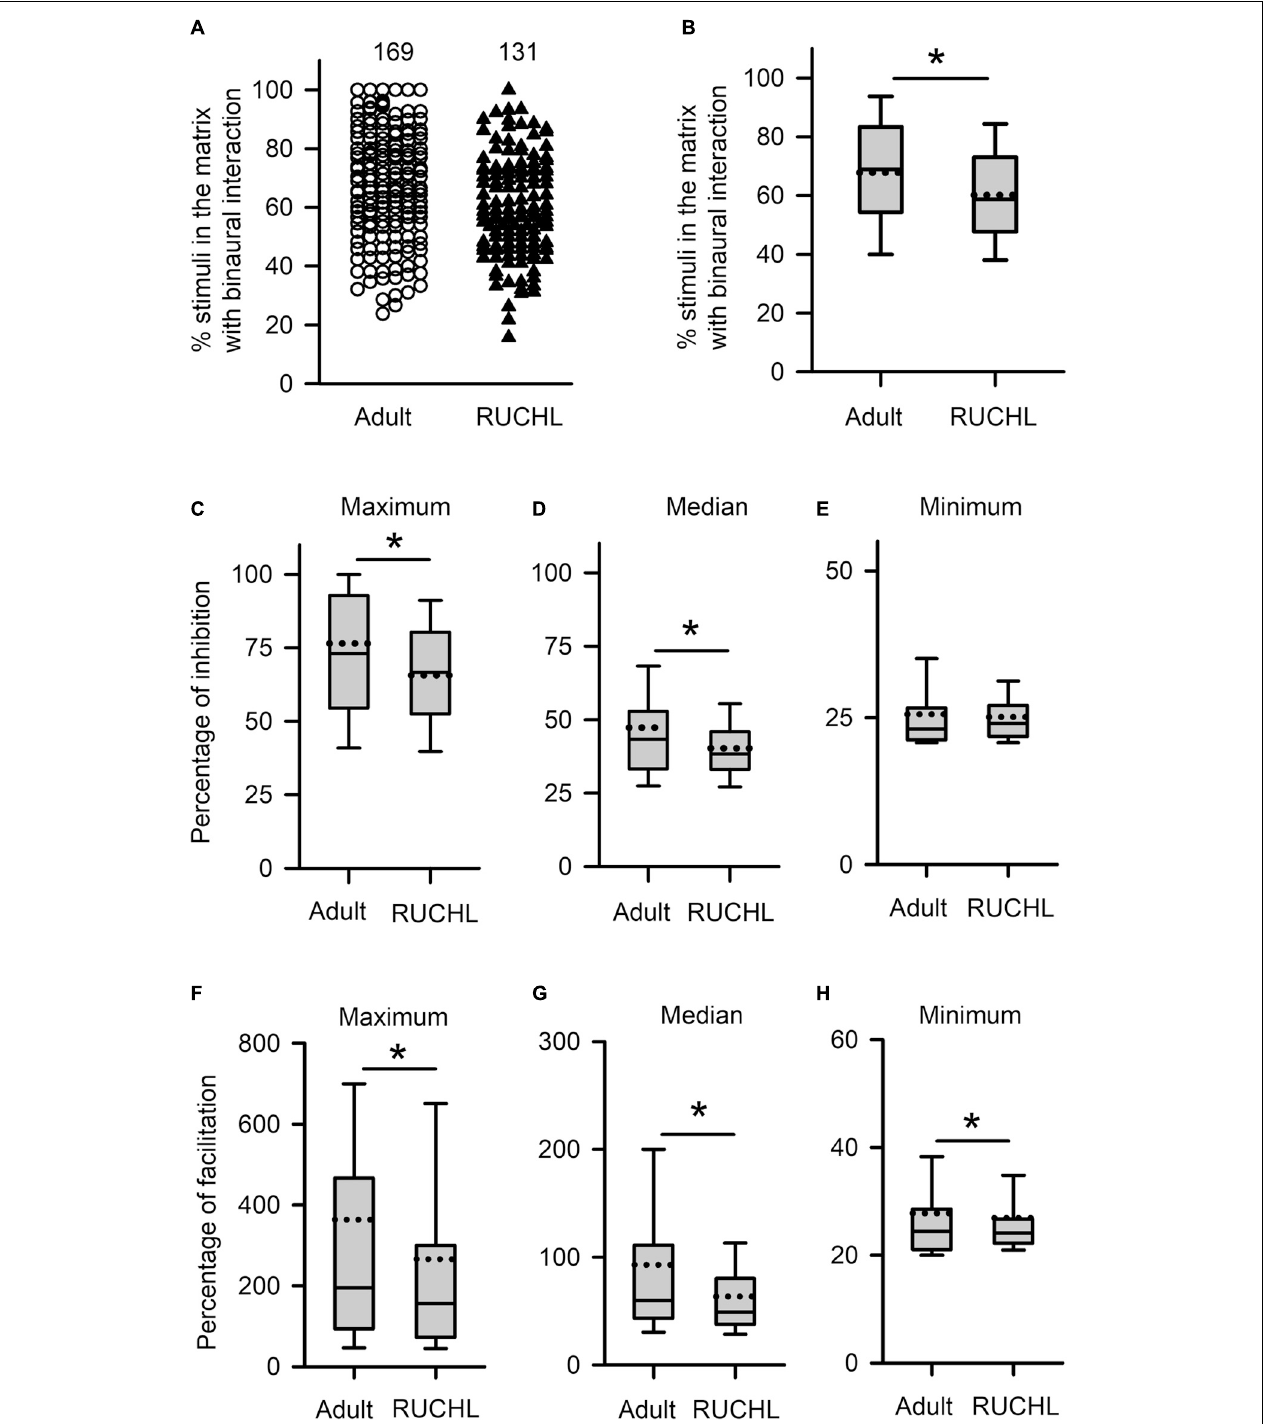
FIGURE 11 | The effects of RUCHL at young age on the degree of binaural interactions of AI neurons in adulthood. (A,B) Scatter plot (A) and box plot (B) showing the distributions in the percentages of stimuli that evoked binaural interactions in the binaural matrix. Each symbol in panel A represents the data from one neuron. The numbers indicate the number of neurons in each group. (C–E) Box plots showing the comparison in the degree of inhibitory binaural interaction between the two groups of AI neurons. The population data for the percentages of inhibition in maximum (C) , media (D) , and minimum (E) are determined from each AI neuron in each group of rats. (F–H) Box plots showing the comparison in the degree of facilitatory binaural interaction between the two groups of AI neurons. The population data for the percentages of facilitation in maximum (F) , media (G) , and minimum (H) are determined from each AI neuron in each group of rats. * indicates significant difference between two groups (Mann–Whitney U -test, p <